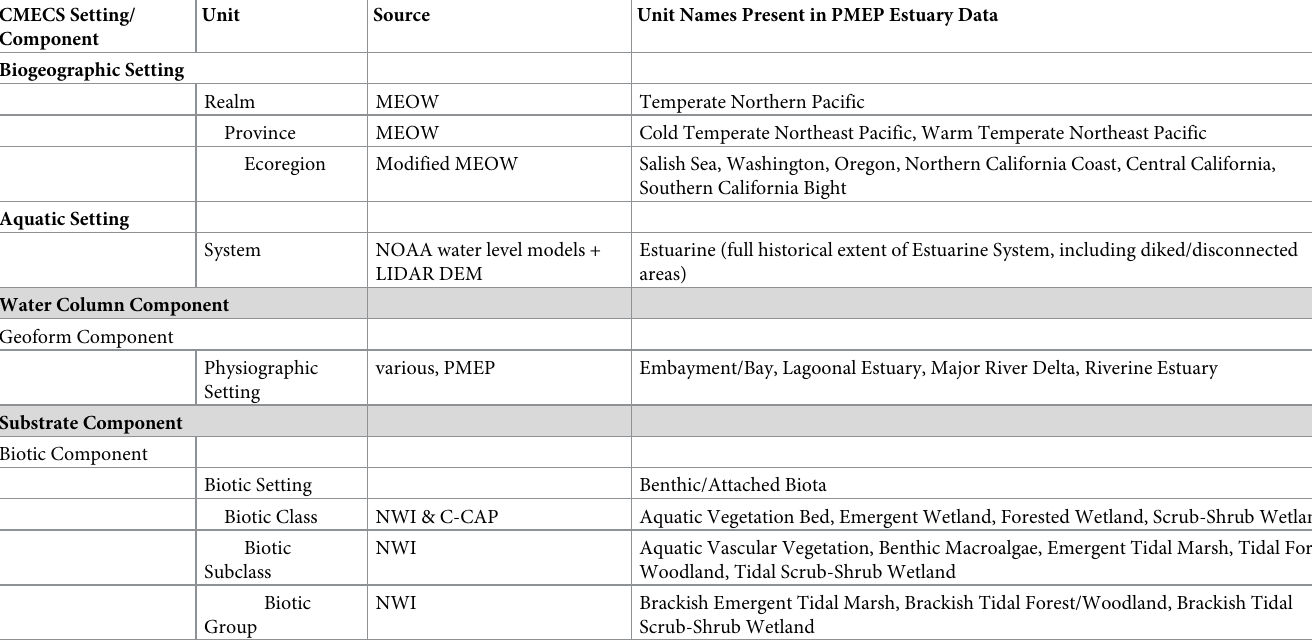
Table 2. CMECS classifications used in unit definition, and sources of information used to make classifications. Abbreviations: MEOW = Marine Ecoregions of the World, PMEP = Pacific Marine and Estuarine Fish Habitat Partnership, NWI = National Wetlands Inventory, C-CAP = Coastal Change Analysis Program. CMECS Setting/